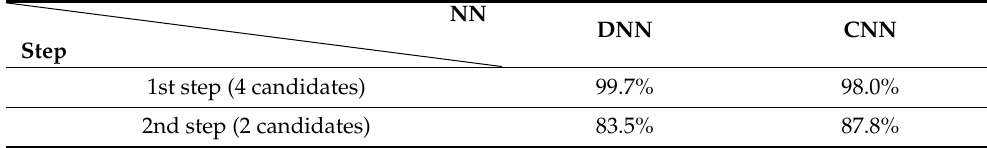
Figure 9. Confusion matrix of the two-step classification (DNN for the 1st step and CNN for the 2nd step). Table 6. Classification accuracy of two-step classifier according to types of NN.